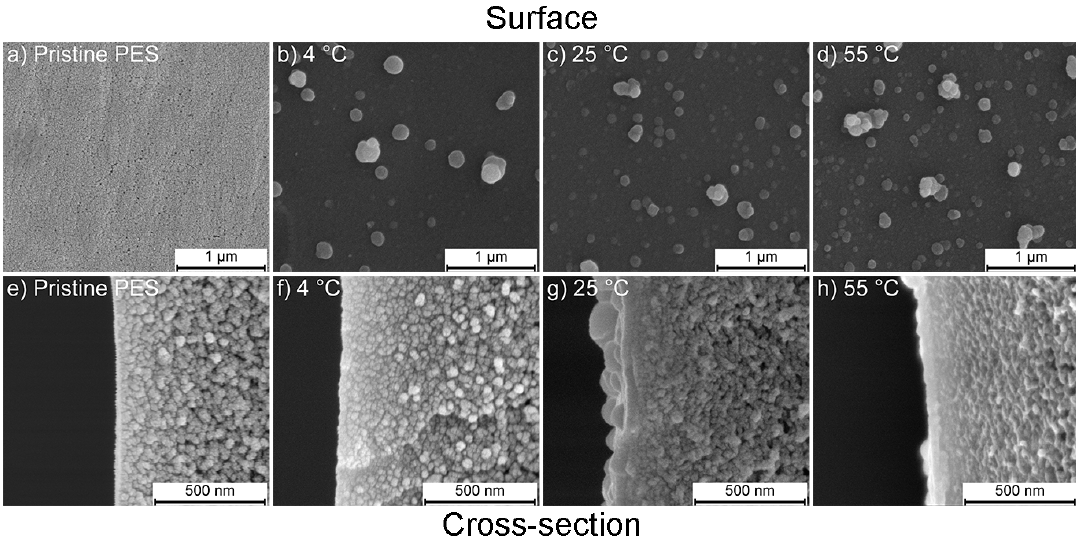
Figure 4. FESEM images that show the effect of coating temperature on the morphology of the membranes coated with 2.0 g/L dopamine. Surface and cross section images of ( a,e ) pristine PES support; ( b,f ) 4 °C; ( c,g ) 25 °C; ( d,h ) 55 °C at a magnification of 100,000× (scale bar: 1 µm) and 250,000× (scale bar: 500 nm), respectively. Figure 3a,c,e,g was added to make comparison easier.